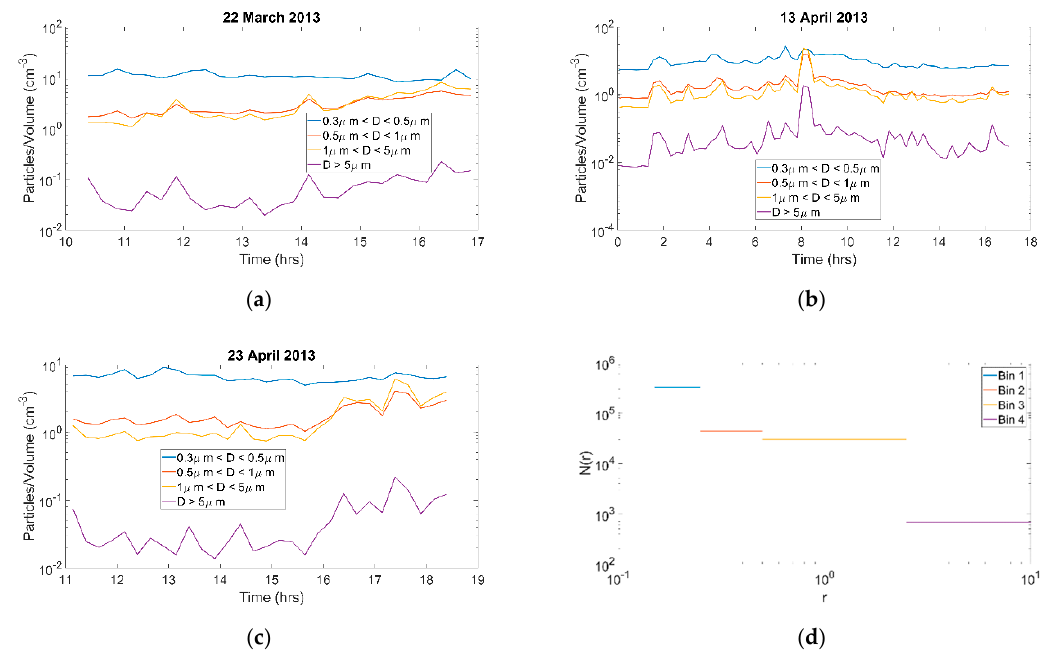
Figure 2. ( a – c ) correspond to particle size distribution throughout the day on the selected representative days used to perform the inter-comparisons between the model’s scattering coefficients and the photoacoustic extinctiometer (PAX)’s corresponding results; ( d ) number of particles per unit volume and radii intervals (bins). From each graph, it is possible to observe and deduce a higher concentration of smaller size particles.